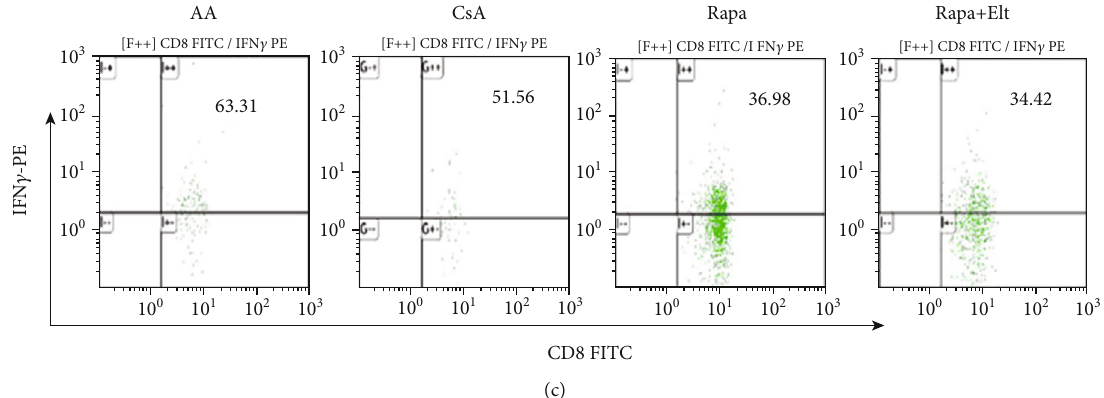
Figure 6: E ffi cacy of rapamycin combined with eltrombopag on T lymphocytes subsets. (a) Column diagram of the e ffi cacy of rapamycin combined with eltrombopag on CD4+/CD8+T ratio and the secretion IFN- γ in CD8+T cells. Compared with the NC group, the AA group showed a decreased CD4+/CD8+ ratio ( P < 0 : 05 ). The results showed that the CD4+/CD8+ ratio in the CsA group, Rapa group, and Rapa + Elt group had an obvious elevation than the AA group (all P < 0 : 05 ). There was no signi fi cant di ff erence among the e ff ect of Rapa, CsA, and Rapa+Elt on the CD4+/CD8+ ratio. As for IFN- γ , Rapa can reduce the secretion of IFN- γ from CD8+T cells with e ffi cacy similar to that of the standard dose of CsA and had a better outcome when combined with Elt in bone marrow failure mice. (b) Representative fl ow cytometry analyses of CD4+/CD8+T ratio. (c) Representative fl ow cytometry analyses of the secretion IFN- γ in CD8 +T